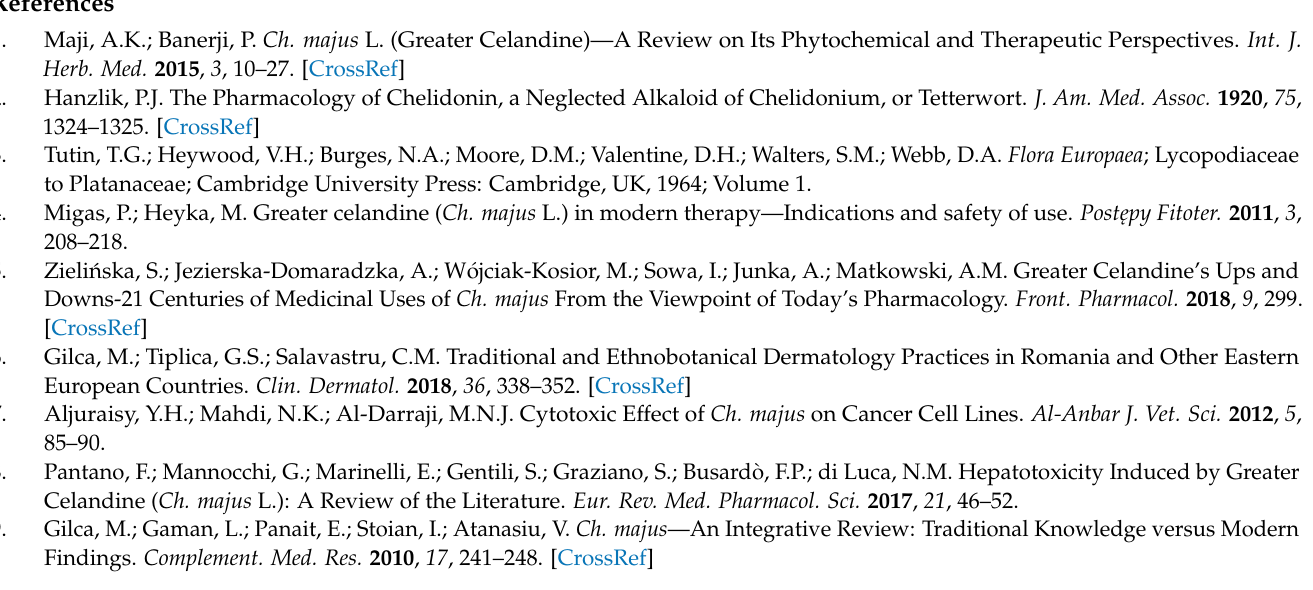
in terms of soil physicochemical properties. Table S2: Spearman rank correlation coefficient between soil elements and rhizomes. Table S3: Spearman rank correlation coefficient between elements in soil and stem. Table S4: Spearman rank correlation coefficient between elements in soil and